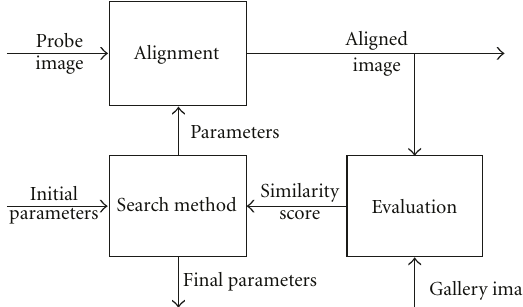
Figure 1: Schematic representation of